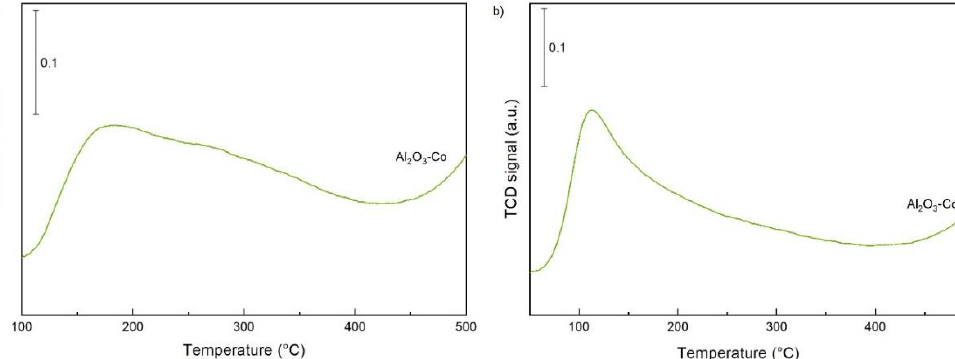
Figure A3. Powder diffraction patterns of used cobalt catalysts.